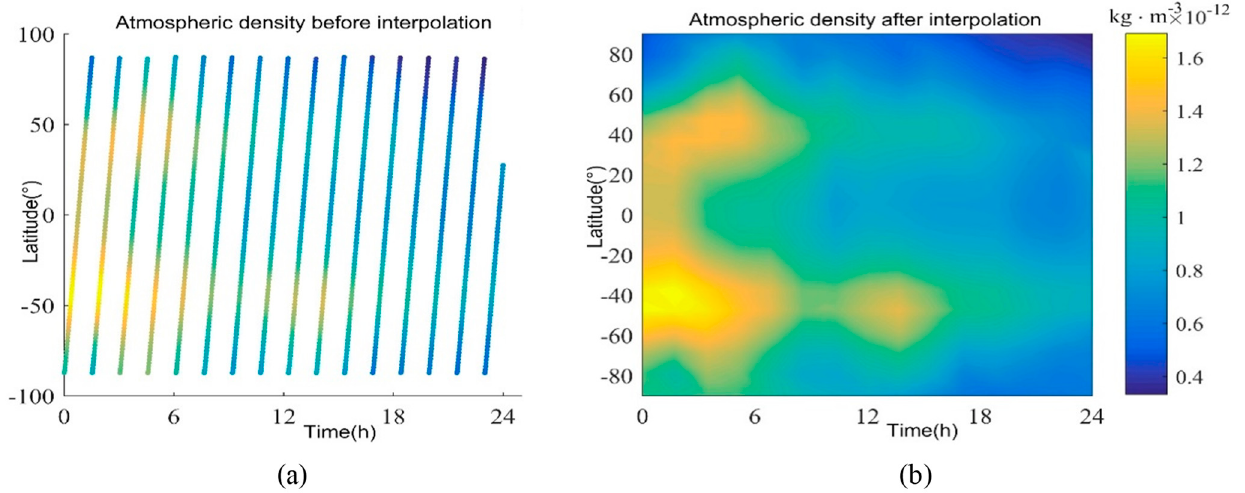
Figure 11. Time–latitude distribution of atmospheric density on 1 January 2016. ( a ) Before interpolation; ( b ) after interpolation.